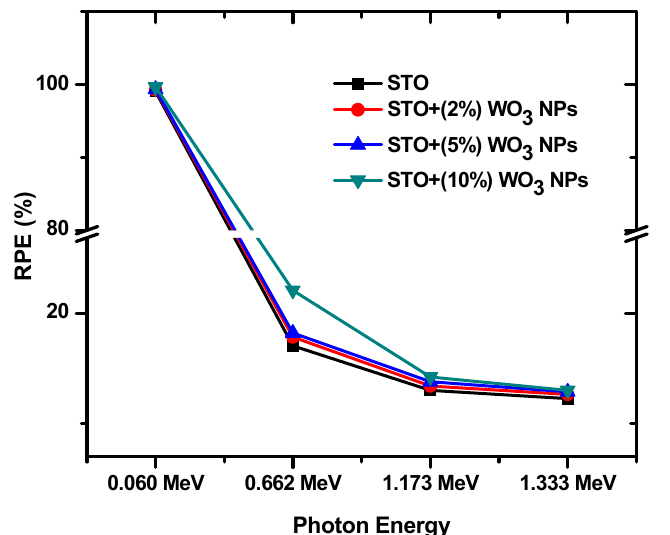
Figure 8. Radiation protection efficiency of STO ceramic and STO ceramic doped with x% of WO 3 NPs.